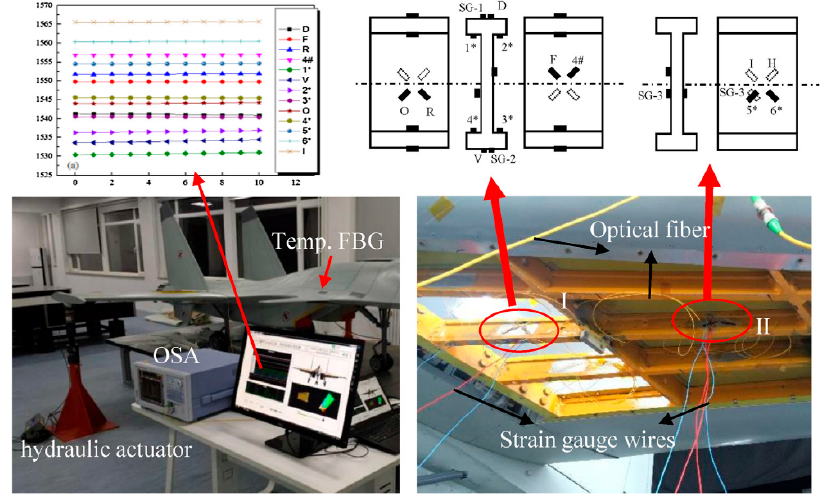
Figure 27. Experimental equipment and sensor installation locations [96].